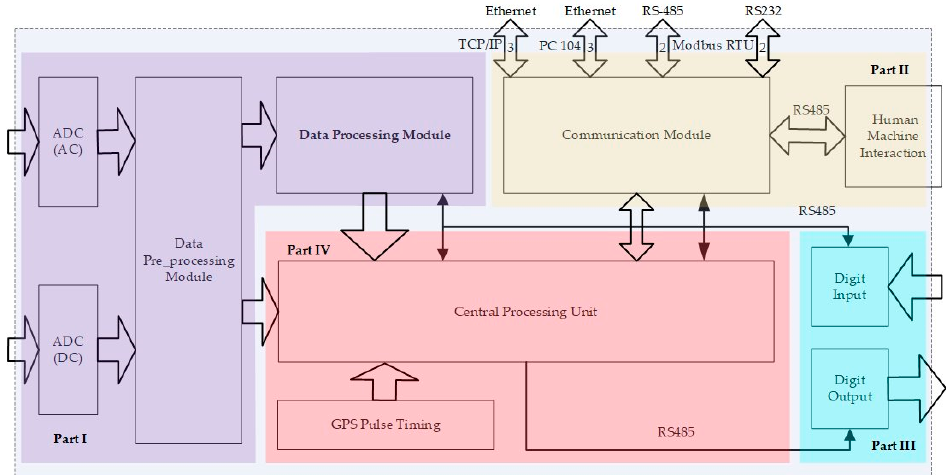
Figure 5. The hardware framework of SCDBS.